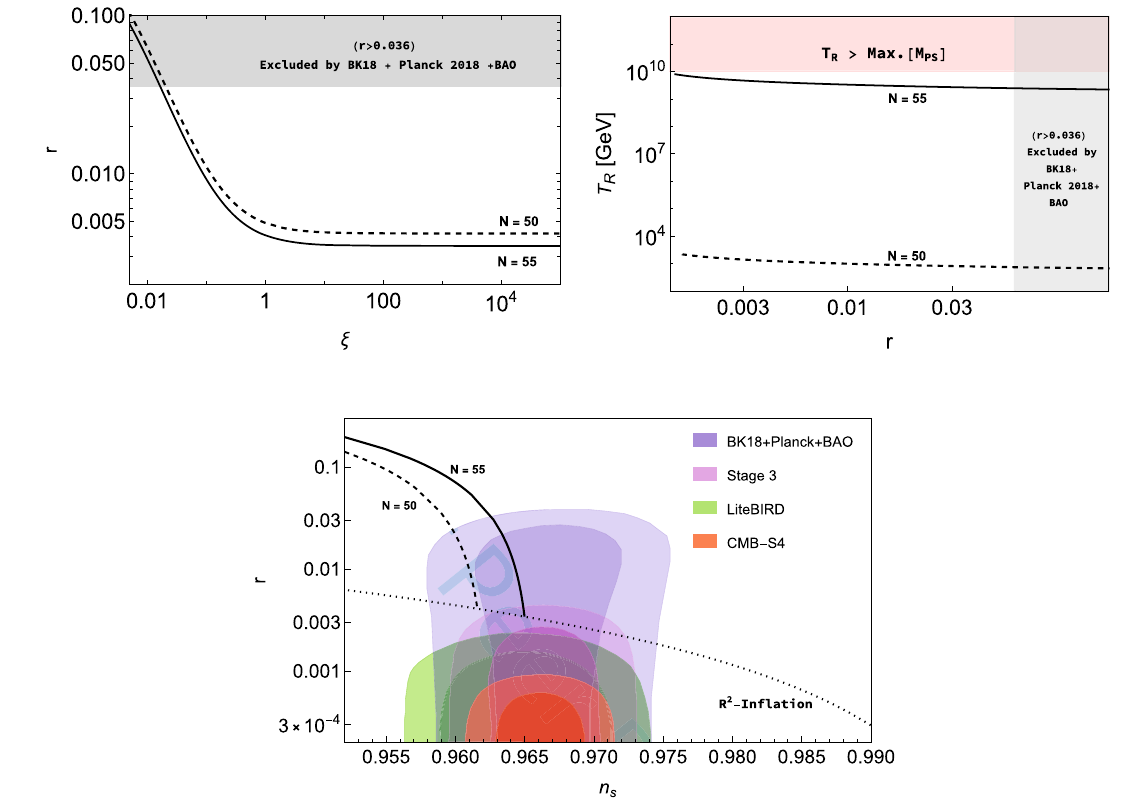
Fig. 5 The top-left panel shows r as a function of ξ for N = 50 and 55 with the shaded region excluded by the current experiments. The top- right panel shows that N (cid:3) 55 is excluded to prevent the restoration of PS symmetry. The bottom panel shows the inflationary predictions for the same N values along with the current best constraints from a